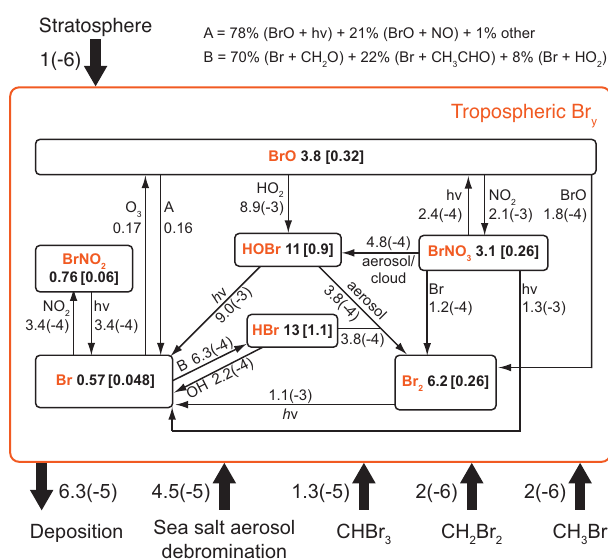
Fig. 3. Global annual mean budget of tropospheric inorganic bromine (Br y ) in GEOS-Chem. The main reactions are indi- cated. Inventories are given as masses (GgBr), with mixing ratios (pmolmol − 1 ) in brackets. Rates are given in units of GgBrs − 1 . Read 6.3( − 5) as 6 . 3 × 10 − 5 . HBr accounts for 55% of Br y loss by deposition. Sea-salt aerosol debromination is the dominant global source of Br y but is mainly confined to the marine boundary layer where Br y has a short lifetime against deposition. It accounts for 48% of the Br y source in the global free troposphere.